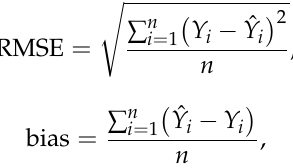
Figure 3. Box-and-whiskers plot ( a ) and histogram ( b ) of soil oxalate-extractable P in the training and test